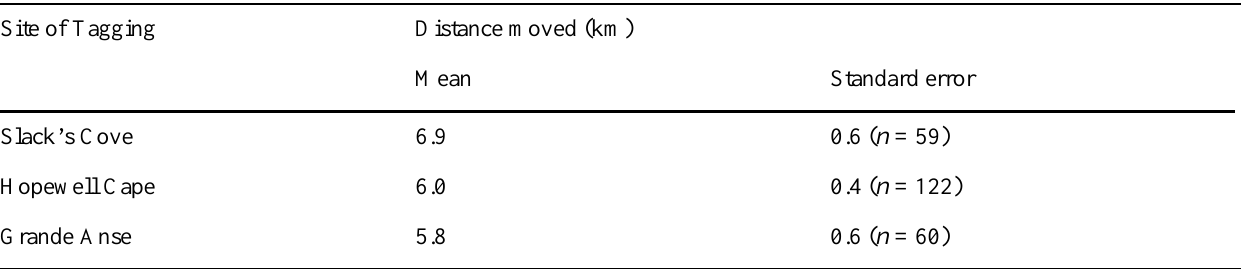
Table 2. Mean distance moved by birds tagged at each of the three capture sites in Chignecto Bay 2005. Number of observations is indicated in